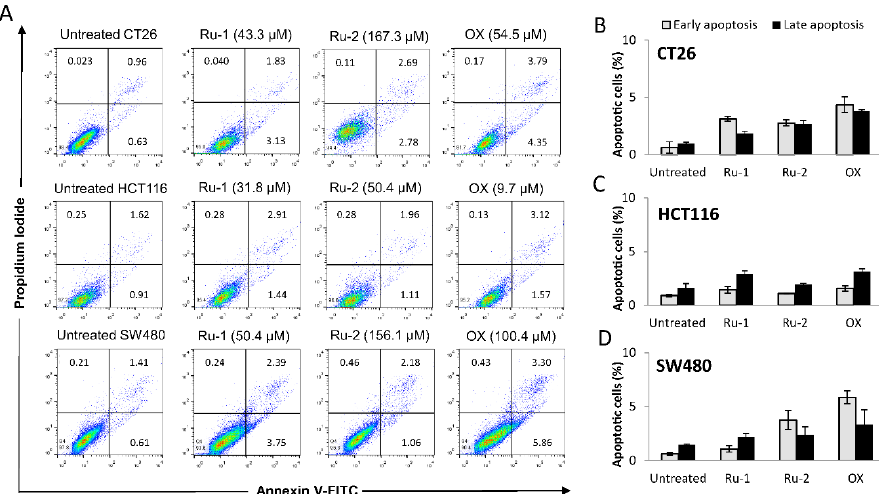
Figure 6. Effects of ruthenium(II) terpyridine complexes on apoptosis in human and murine colon carcinoma cells. ( A ) Representative dot plots illustrate the population of viable (AnnV − PI − ) early apoptotic (AnnV + PI − ), late apoptotic (AnnV + PI + ), and necrotic (AnnV − PI + ) cells. Apoptosis of untreated as well as ruthenium(II) complexes and oxaliplatin-treated ( B ) CT26 cells; ( C ) HCT116 cells; ( D ) SW480 cells were analyzed by flow cytometry using an Annexin V-FITC and PI double staining. The data are presented as means ± SD of three independent experiments.